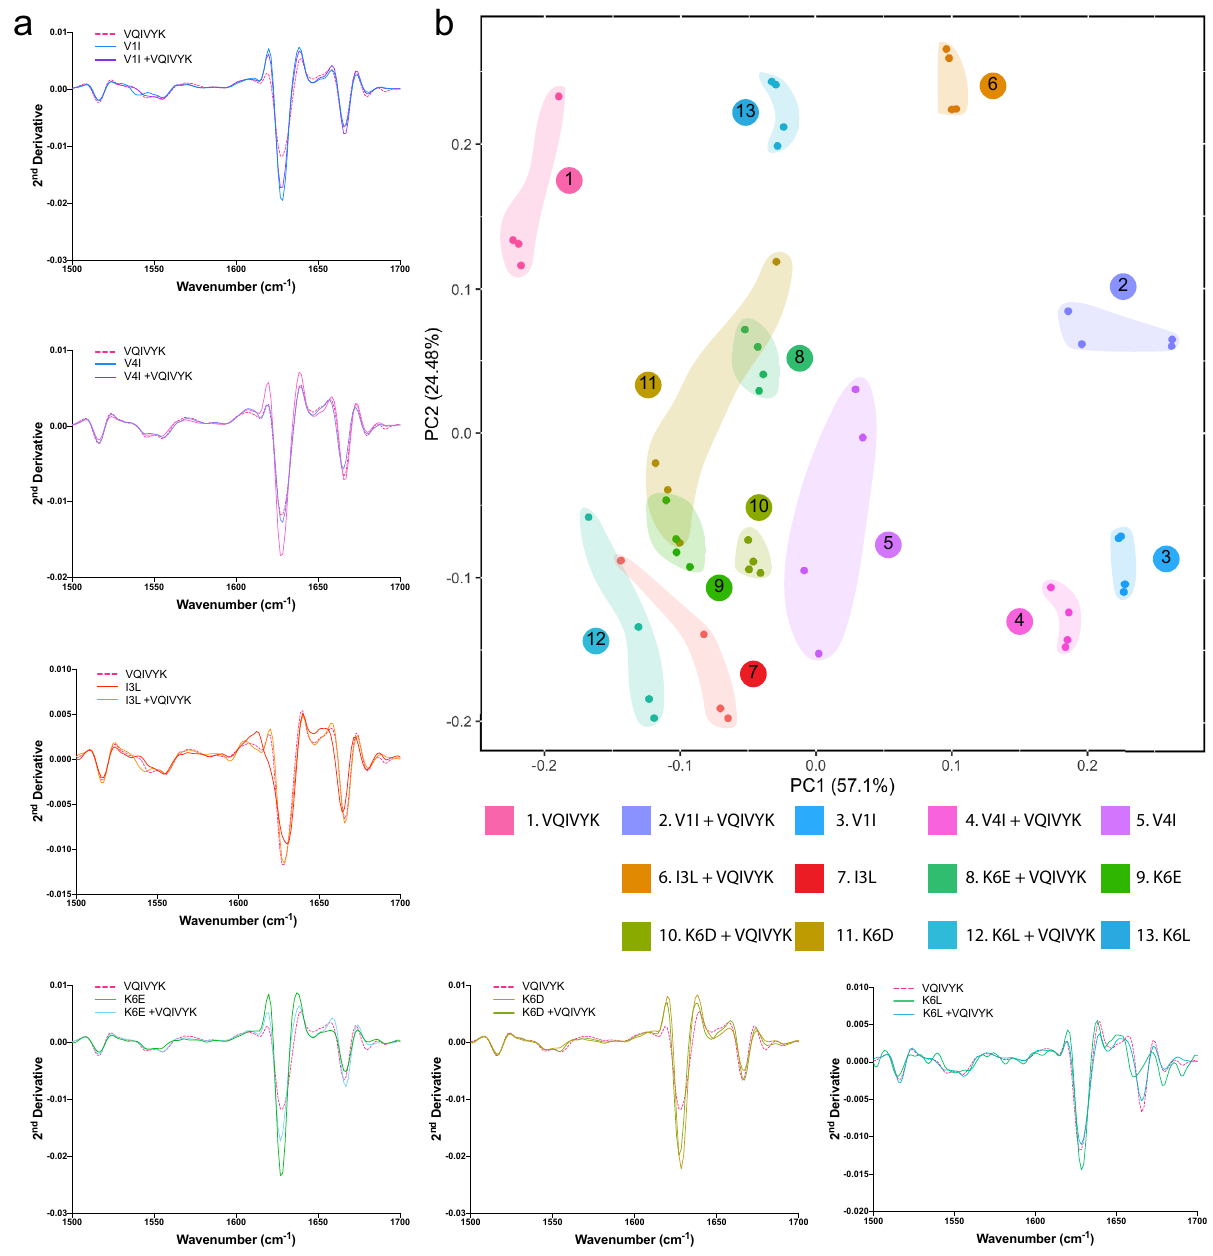
Fig. 7 FTIR spectroscopy coupled to PCA revealed the formation of diversi fi ed conformers in the presence of VQIVYK co-aggregating modi fi ers. a Second derivatives of the FTIR spectra generated from mixed, peptide modi fi er-alone or VQIVYK-alone samples, focused around the amide I and amide II region (1700cm − 1 – 1500 cm − 1 ). b PCA analysis of the derived spectra indicates the presence of different clustering locations in the eigen space representing the formation of differentiated amyloid fi bril conformers in the different samples. For each sample, two individual preparations were split in two independent aliquots and combined in four data points ( n = 4) per sample in order to represent the intrinsic variability in the spectral